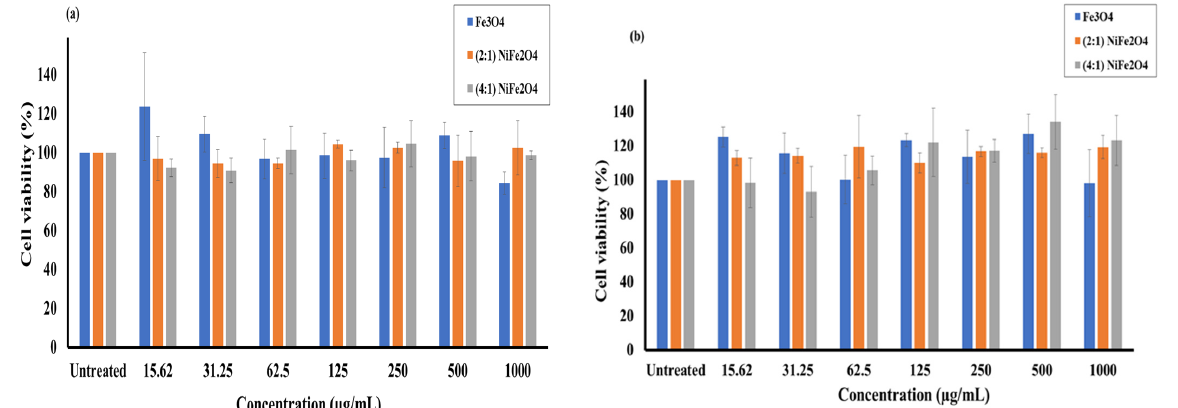
Figure 6. Cell viability of the synthesized Fe 3 O 4 , and spinel (2:1) and (4:1) NiFe 2 O 4 NPs after their incubations for 24 h with ( a ) Hep G2 and ( b ) A549 cell lines. The data are the result of MTS assay expressed as cell viability (%) and presented as the mean ± SD ( n = 3).